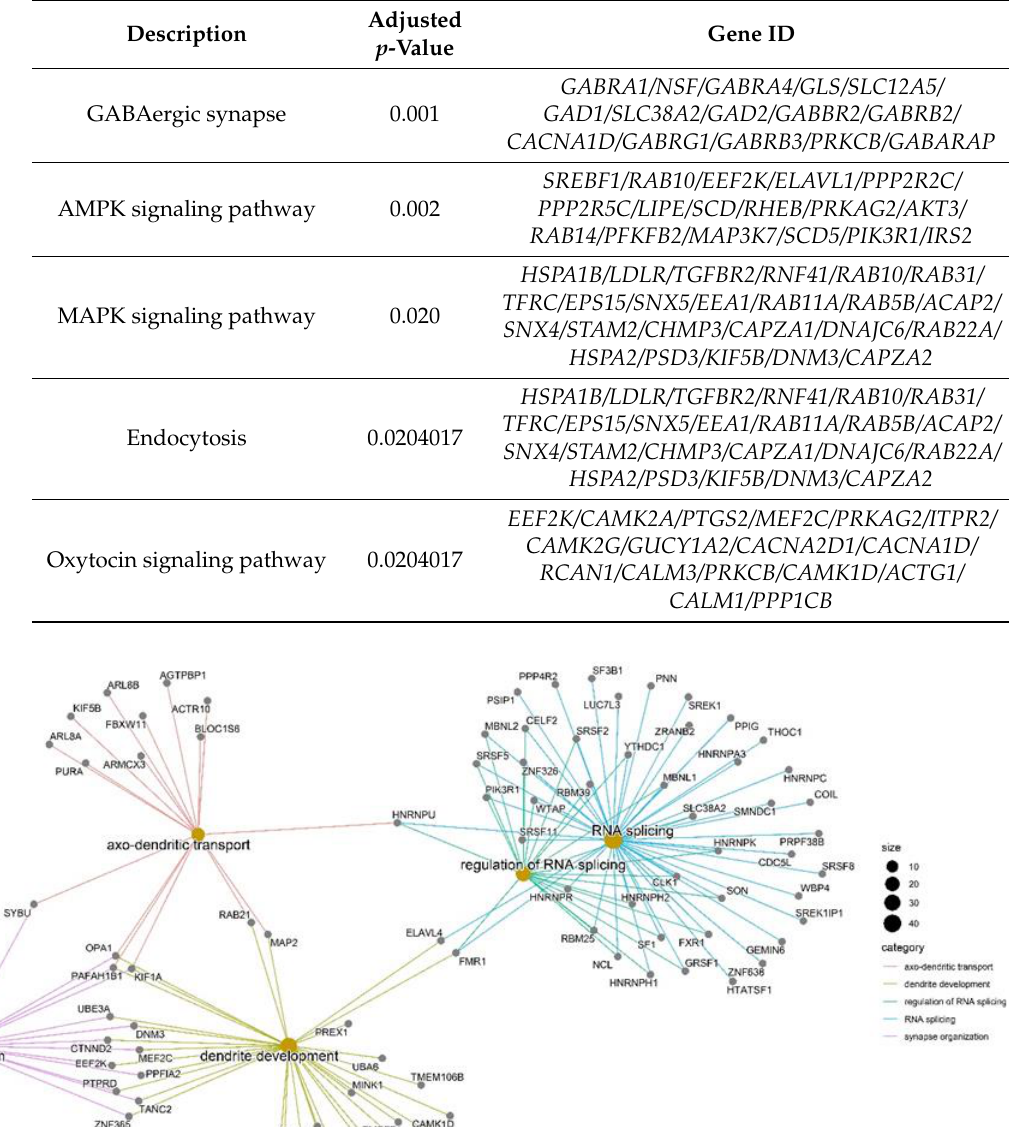
Table 3. Kyoto Encyclopedia of Genes and Genomes pathways enriched for mRNAs involved in the miR-495-3p community.